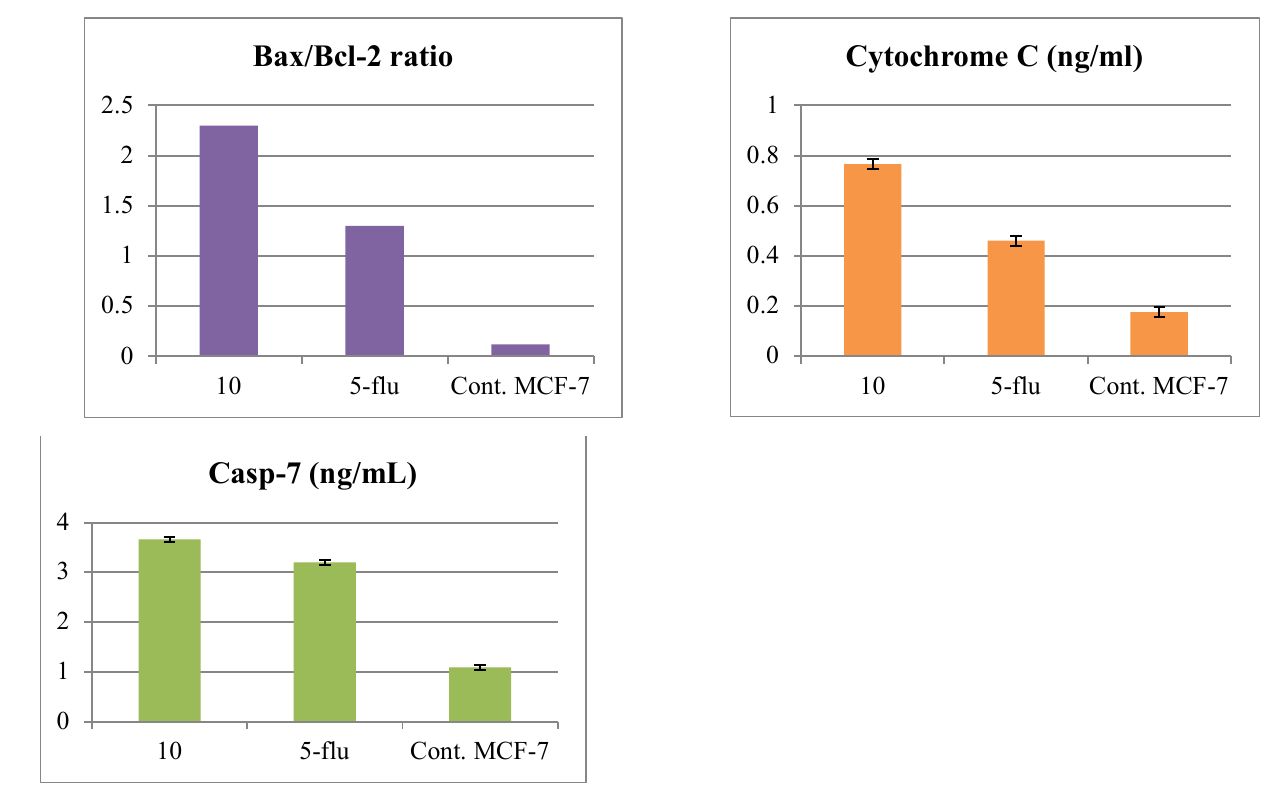
Figure 4. Levels of Bax, Bcl-2, Bax/Bcl-2 ratio, cytochrome c and caspase-7 protein in MCF-7 cells after treatment with compound 10 and the standard drug for 24 h compared with the untreated one, 5-flu: 5-fluorouracil as a reference drug.